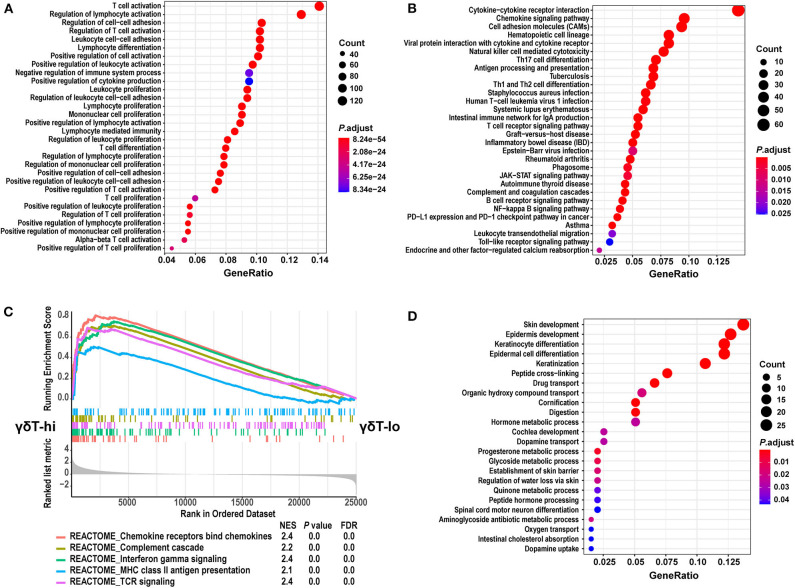
GO and KEGG term enrichment analyses for the differentially expressed genes and GSEA analysis between the γδT-hi and γδT-lo groups. (A) The top 30 enrichment results from GO biological process terms in γδT-hi group. (B) The top 30 enrichment results from KEGG pathway terms in the γδT-hi group. (C) GSEA analysis shows the 5 REACTOME pathways that are enriched in the γδT-hi group. (D) The enrichment results from GO biological process terms in the γδT-lo group. GO and KEGG enrichment analyses were calculated by R package clusterProfiler (version: 3.16.1), the terms were not mutual excluded, adjusted P-values (P. adjust) were calculated by hypergeometric distribution. The size of dots indicates the count of significantly upregulated genes in γδT-hi or γδT-lo group that overlap with the specific geneset in GO or KEGG database, the color of dots indicates the adjusted P-values, red color indicates the smaller adjusted P-values. GeneRatio means the relative proportion of the overlapped genes in the specific dataset in GO or KEGG database. GSEA analysis was performed using the REACTOME database in MSigDB (version 7.1), and P-values for GSEA analyses were calculated by permutation tests. The lower part of (C) shows the genes that are ranked from the most upregulated in γδT-hi group (left side) to the most upregulated in γδT-lo group (right side). The middle part shows the distribution of genes in specific dataset in the ranked list. The upper part shows the running enrichment score of each dataset. NES, normalized enrichment score; FDR, false discovery rate.